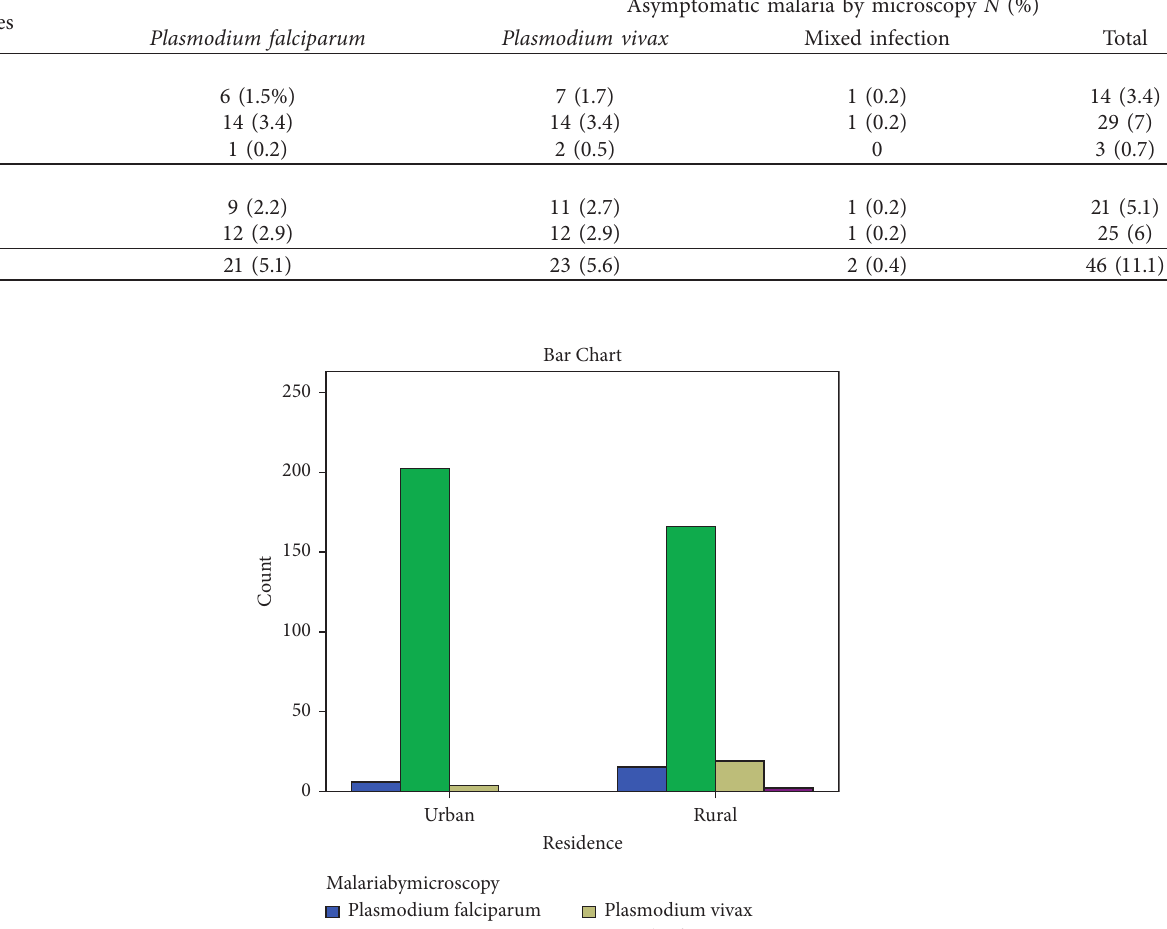
Table 2: The prevalence of asymptomatic malaria among age and sex groups of primary school children in Gedeo zone, Ethiopia. Variables